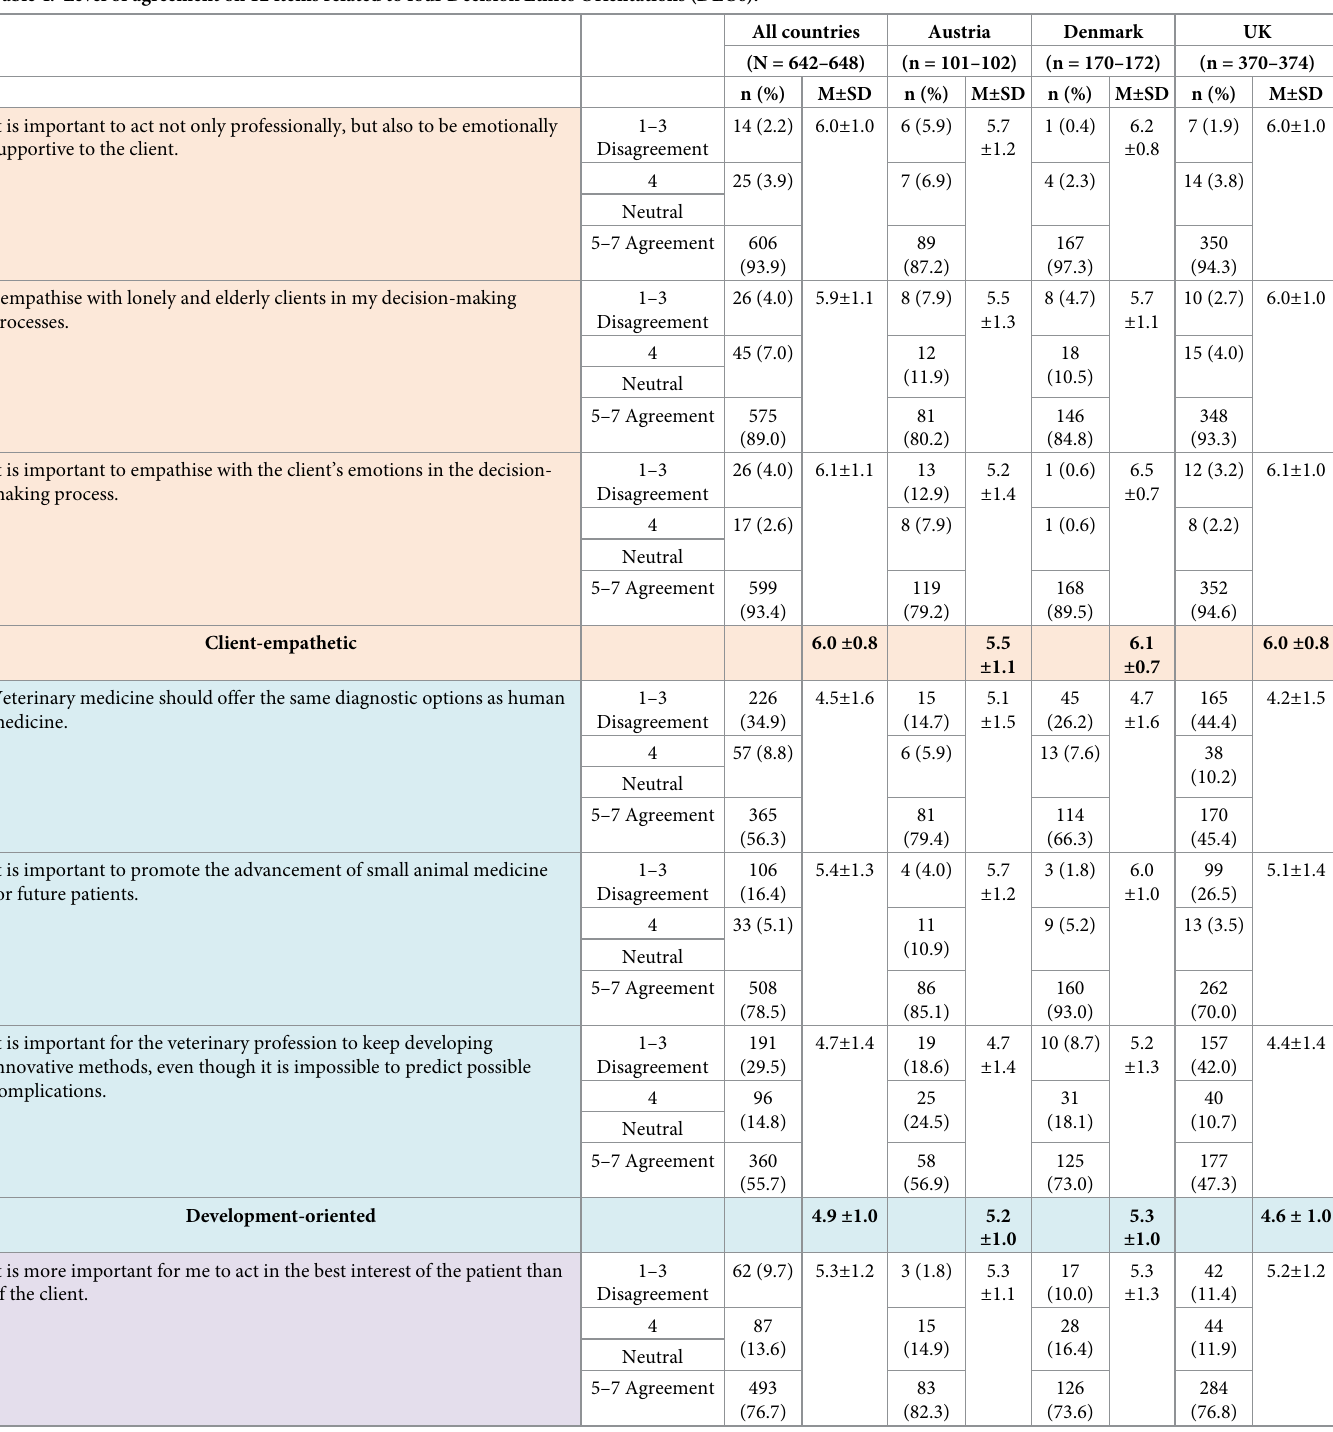
Table 4. Level of agreement on 12 items related to four Decision Ethics Orientations